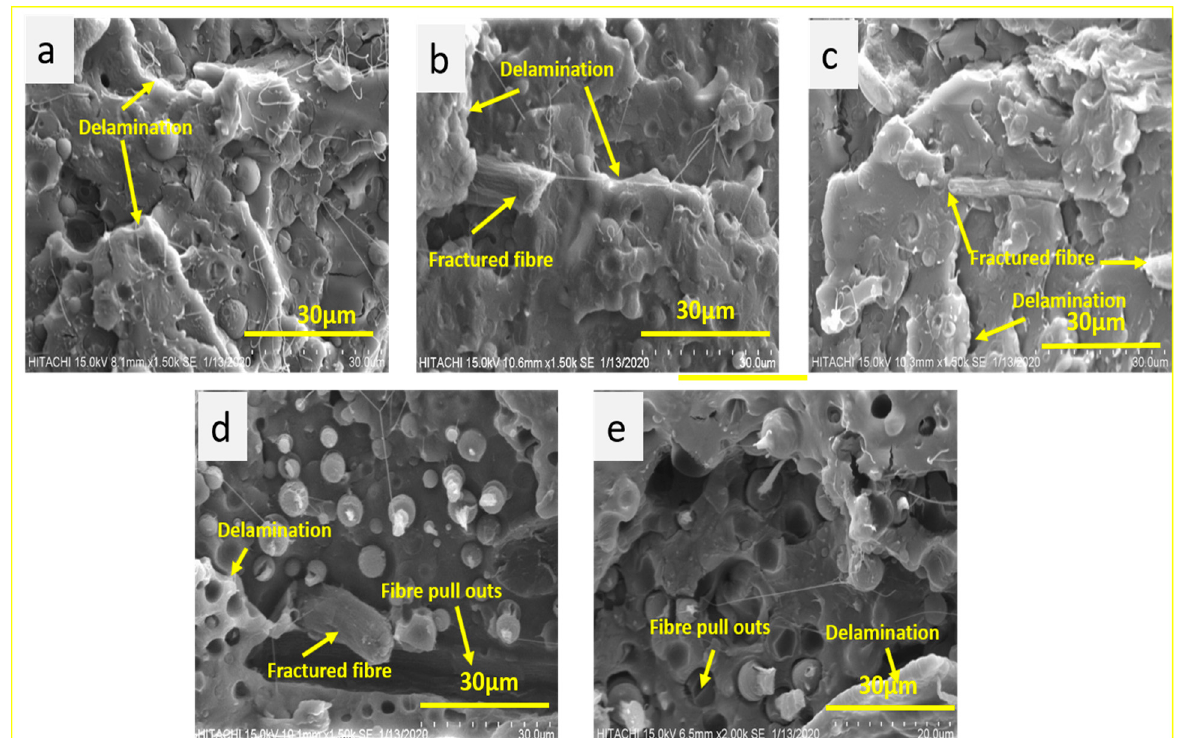
Figure 8. SEM morphology of the tensile tested (fractured) surfaces composites, ( a ) N1, ( b ) N2, ( c ) N3, ( d ) N4, ( e ) N5.